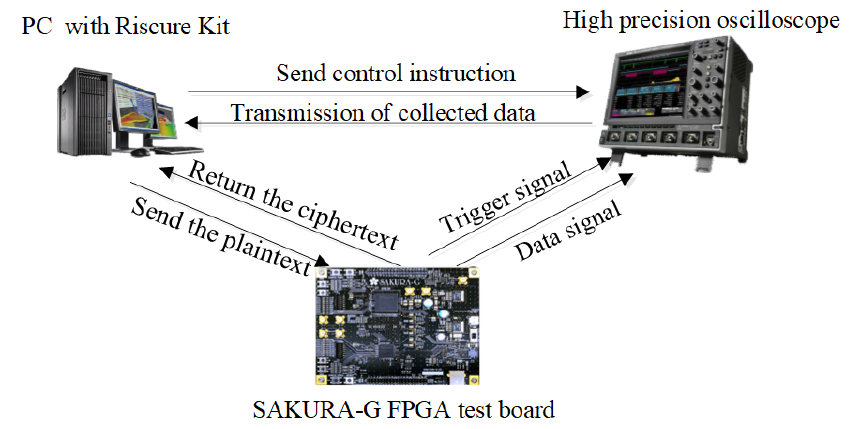
Figure 2. Measurement environment.